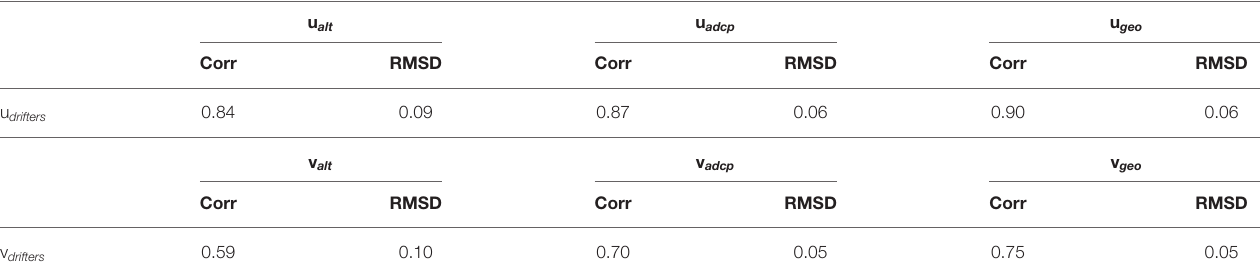
TABLE 1 | Correlation coefficients (Corr) and root mean square differences (in m s − 1 , RMSD) between the zonal and meridional components of the drifter velocity and the same components of the altimetric, ADCP and geostrophic velocities interpolated onto the drifter position (altimetric velocity was previously interpolated in time along the drifter time axis). u alt u adcp u geo Corr RMSD Corr RMSD Corr RMSD u drifters 0.84 0.09 0.87 0.06 0.90 0.06 v adcp v geo RMSD Corr RMSD Corr RMSD v drifters 0.59